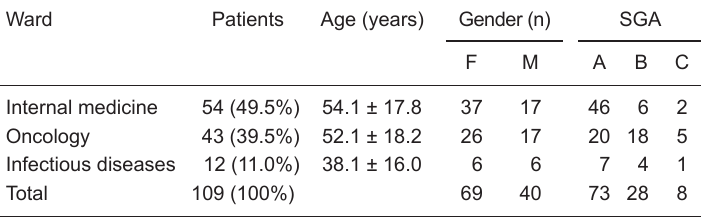
Table 1. Distribution of patients in this study as a function of hospital ward, age, gender, and nutritional status according to the Subjective Global Assessment (SGA) at the Hospital de Clínicas, Universidade Federal de Uberlândia.